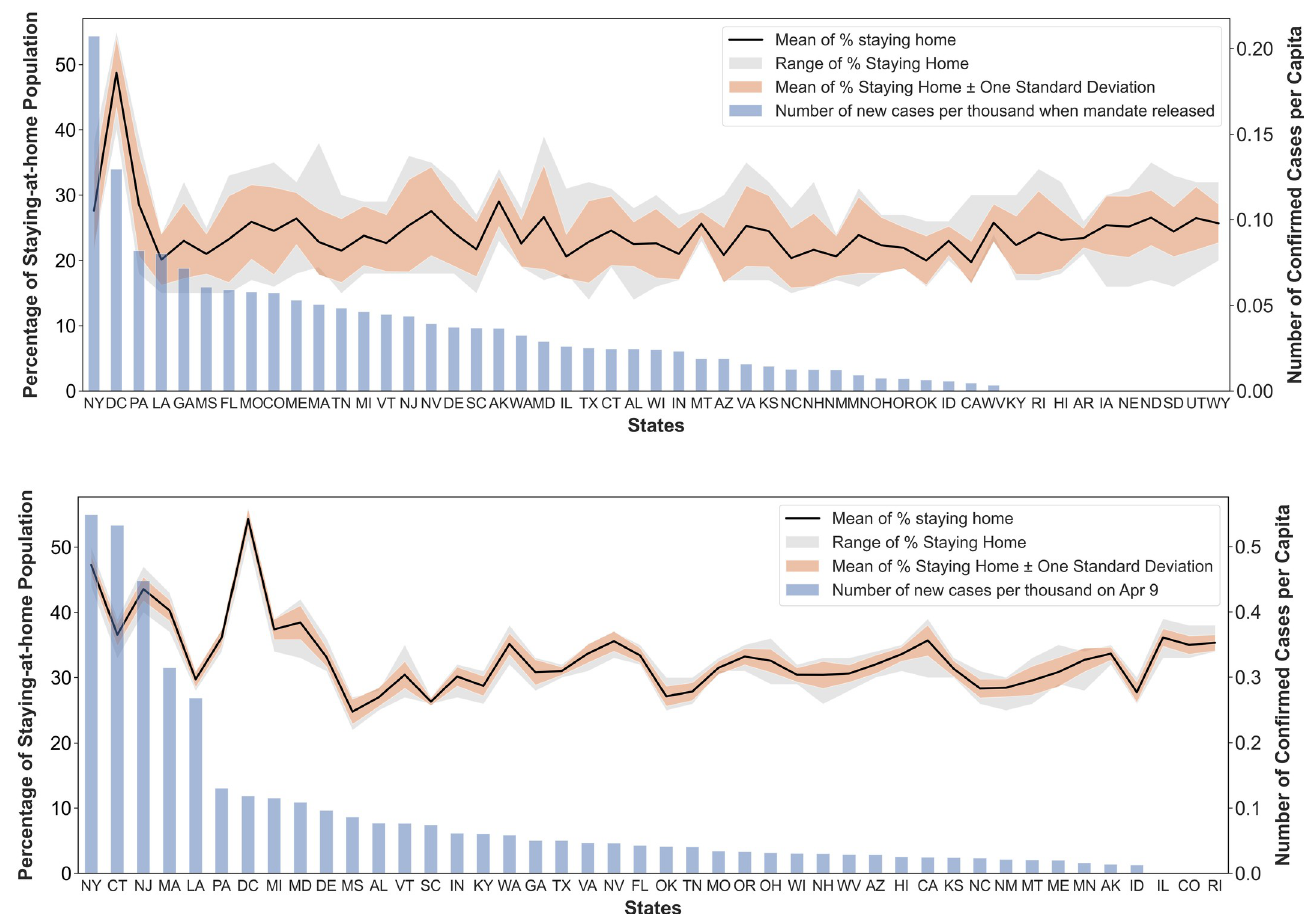
Fig 6. Statewide variations on the percentage of people staying at home by two timelines. (a) Percentage of people staying home between the first confirmed case and stay-at-home order (upper); (b) Percentage of people staying home after the stay-at-home order (lower).